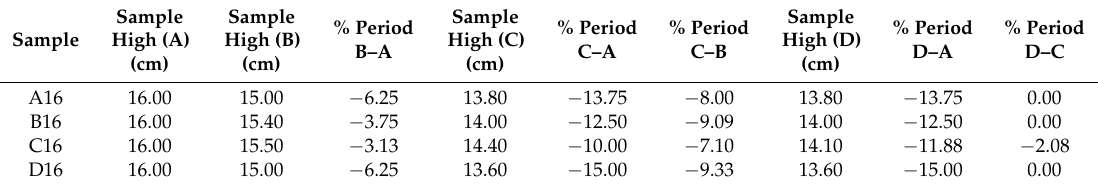
Table 1. Data measured during the first year of natural compaction: 1st measurement: 31.03.2014